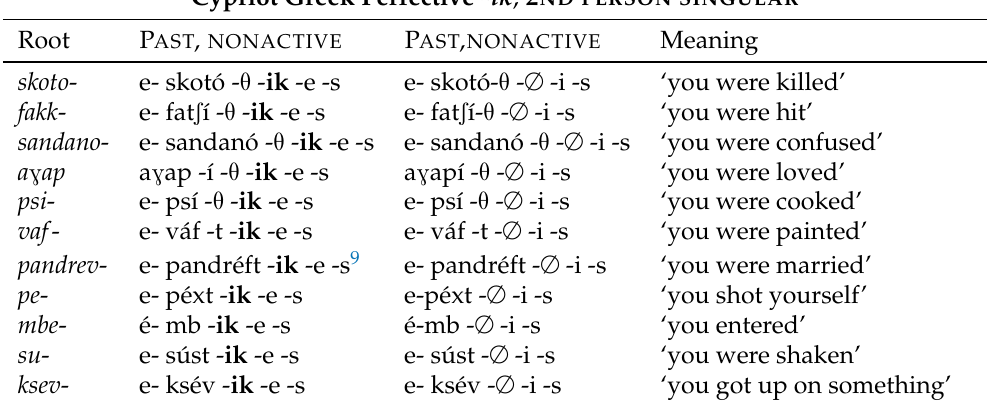
Table 2. The perfective -ik in 2 ND P ERSON S INGULAR